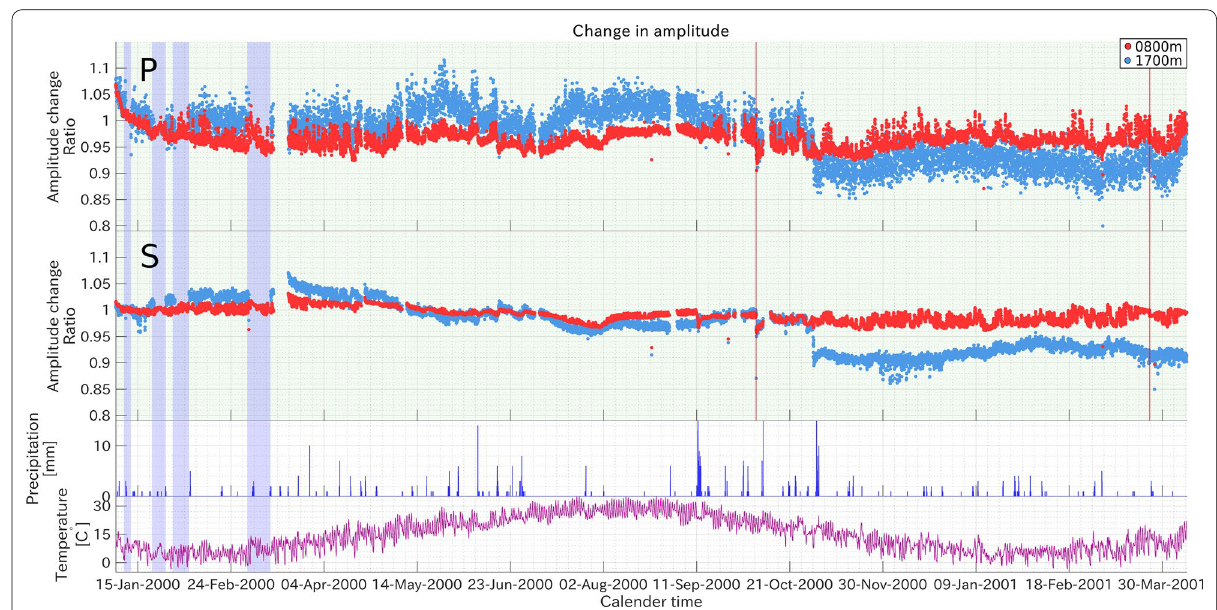
Fig. 13 Changes in amplitude of the azimuthal invariant value. Changes in amplitude for P-UD and the azimuthal invariant value are shown in the top and second panels. The atmospheric temperature and rainfall are shown in the third and bottom panels. Periods with blue shading show the periods of the water injection experiments. The red vertical lines show the time of the WT and GY earthquakes